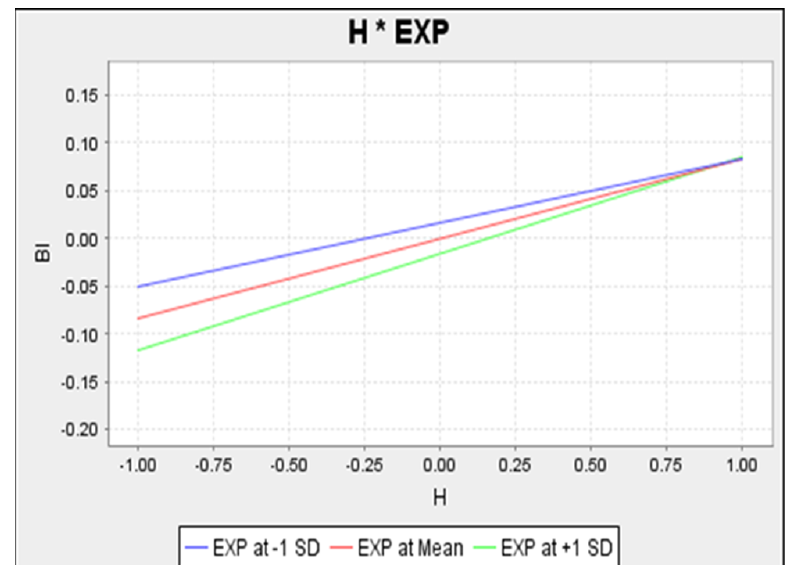
Figure 5. Simple Slope Analysis of Effort Expectancy on Behavioural Intention. Figure 6 shows that the upper line, representing a low level of moderation (experi- ence), is flatter in slope, whereas the lower line, representing a high level of moderation (experience), takes on a steeper slope. The positive relationship shows that the relationship is less positive among users with high experience compared to users with low experience.